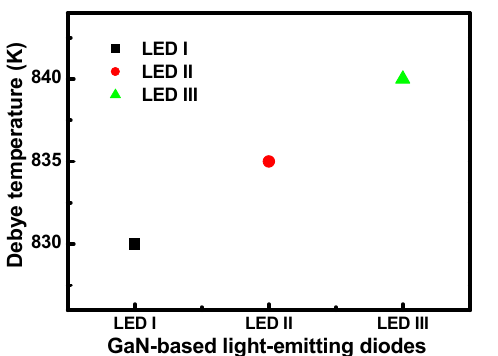
Figure 4. The Debye temperatures as a function of the LED structures for samples LED I, LED II, and LED III.